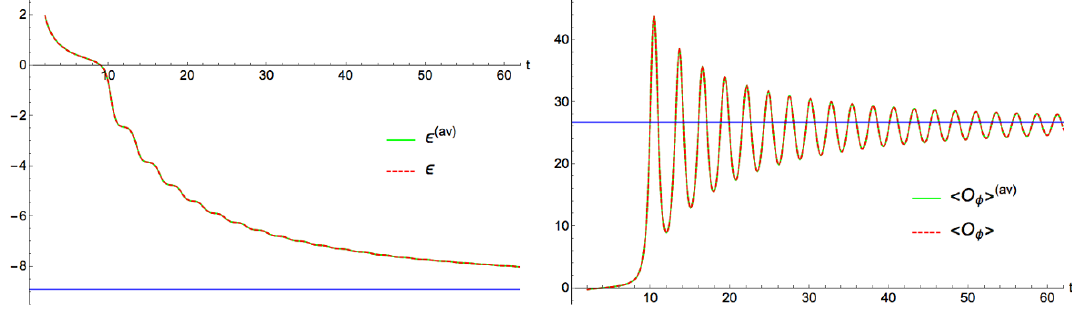
Figure 13 . Comparing the mean value of energy density and expectation value of the scalar (cid:12)eld for inhomogenous evolution (green solid line) with the homogenous one (dashed red line) for the class B potential. Again the blue horizontal lines correspond to the smallest black hole solutions which we expect to be the late time state of the boost invariant expansion.